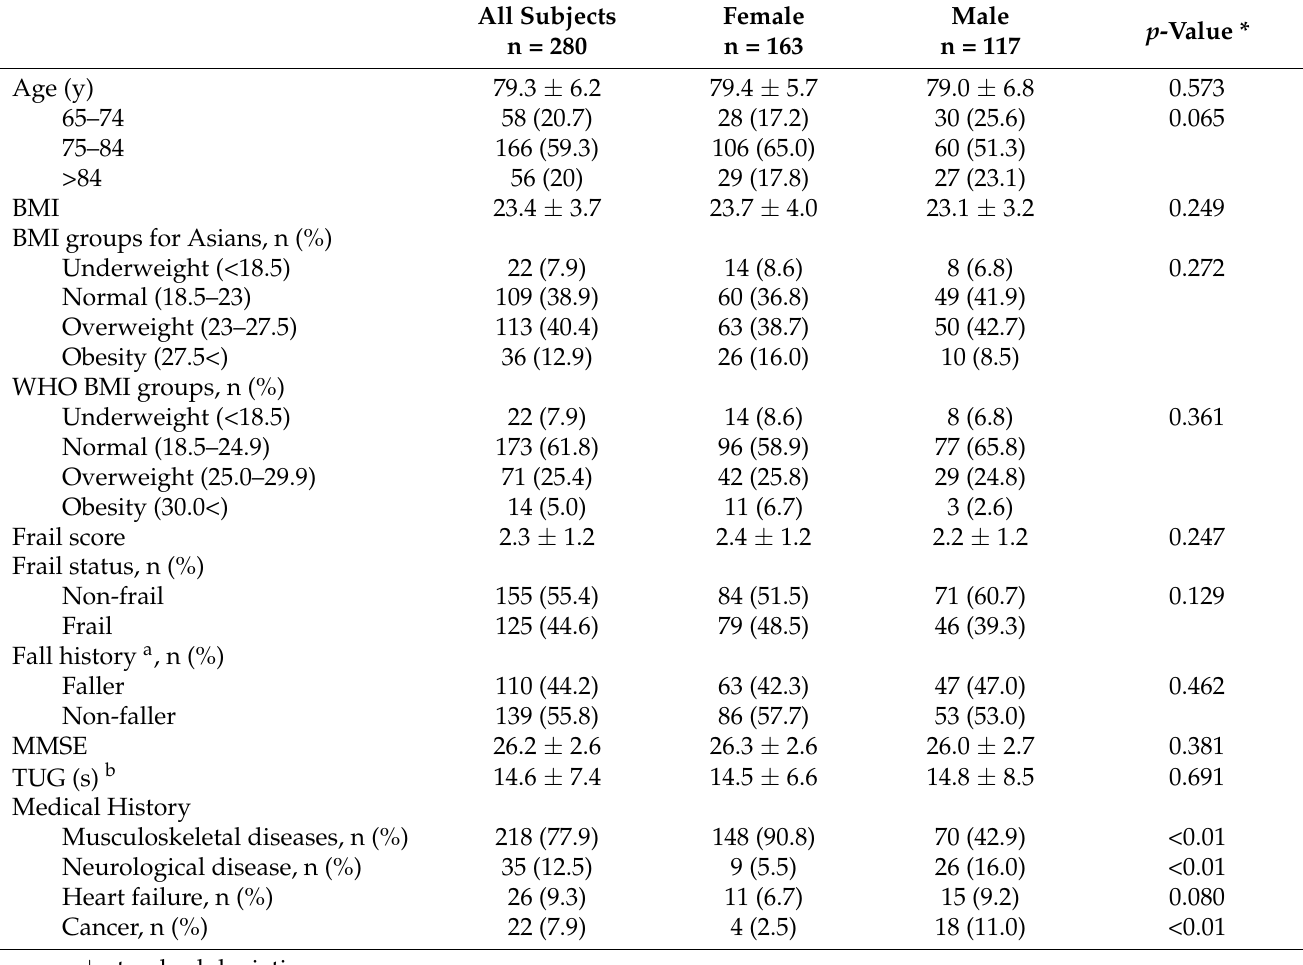
Table 1. Demographic characteristics of